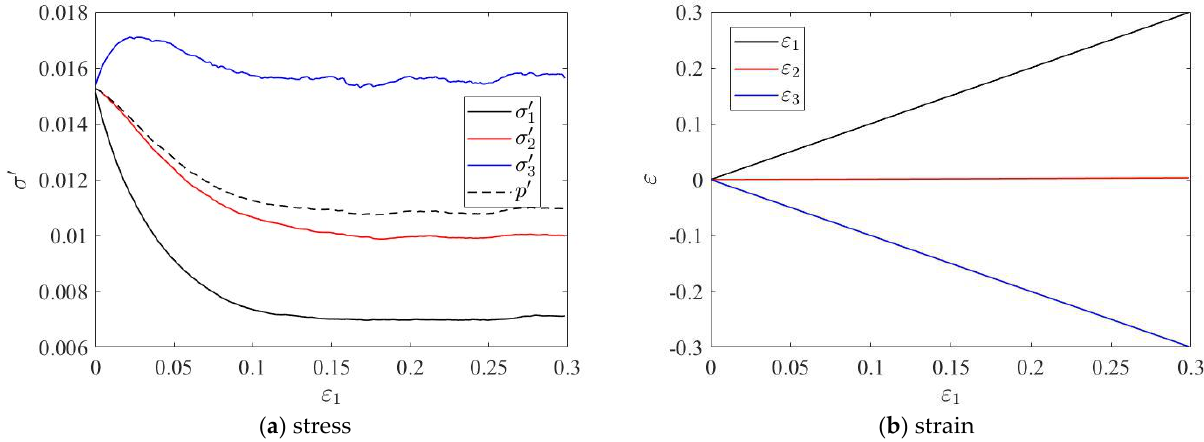
Figure 5. An isochoric shear